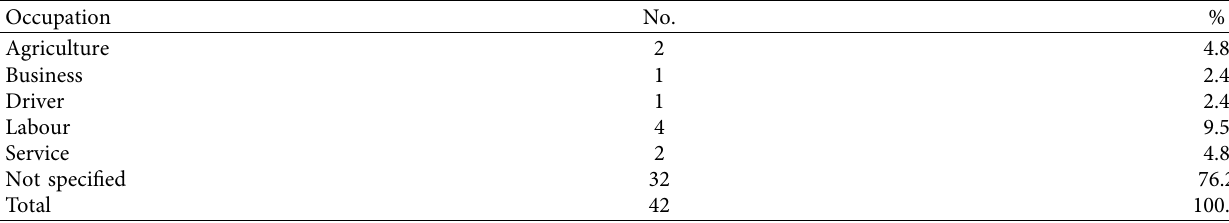
Table 6: Distribution of occupation among blood donors with COVID-19 IgG positive status.